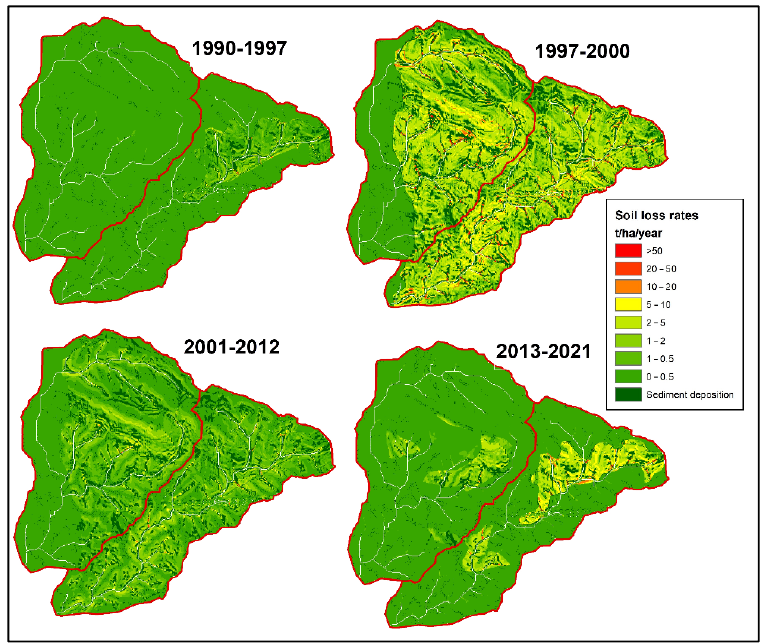
Figure 6. Spatial distribution of the mean annual soil erosion rate for the different investigated periods and land-use patterns.